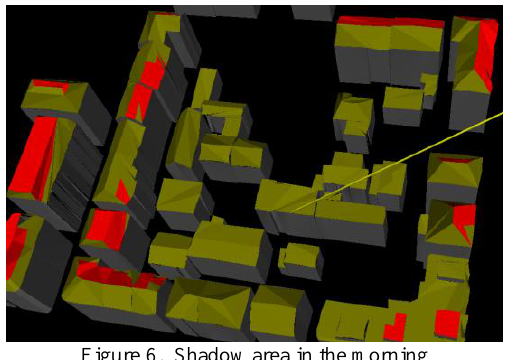
Figure 6. Shadow area in the morning